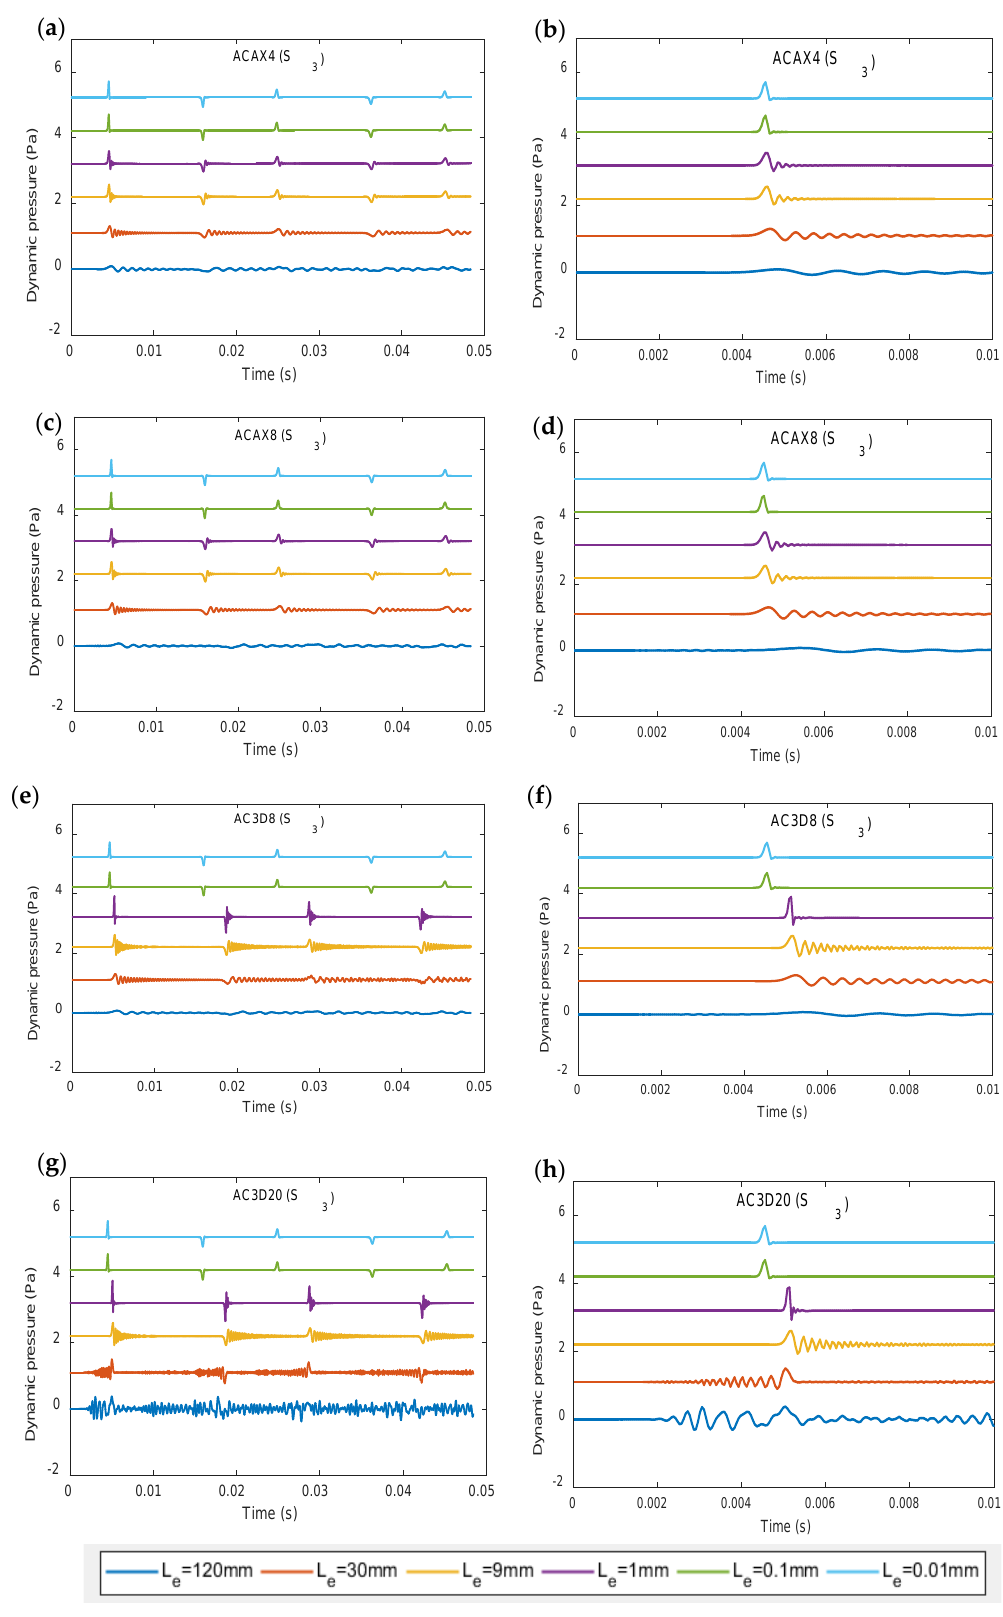
using ACAX4, ACAX8, AC3D8 𝑟𝑟 3